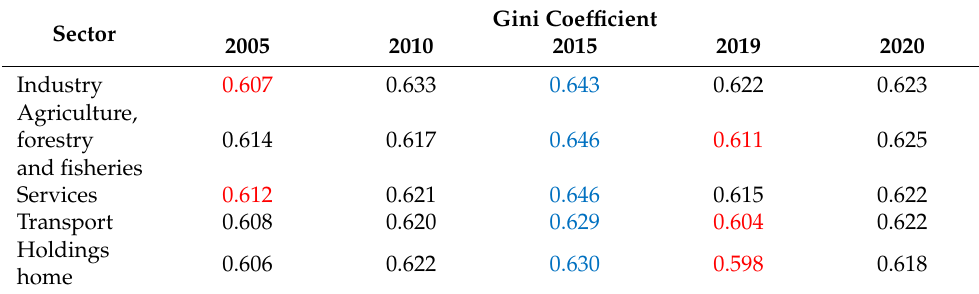
Table 1. Estimated Gini coefficient values for final energy consumption by sector and area in EU countries from 2005 to 2020. Blue indicates the best performer in a given period, and red the worst